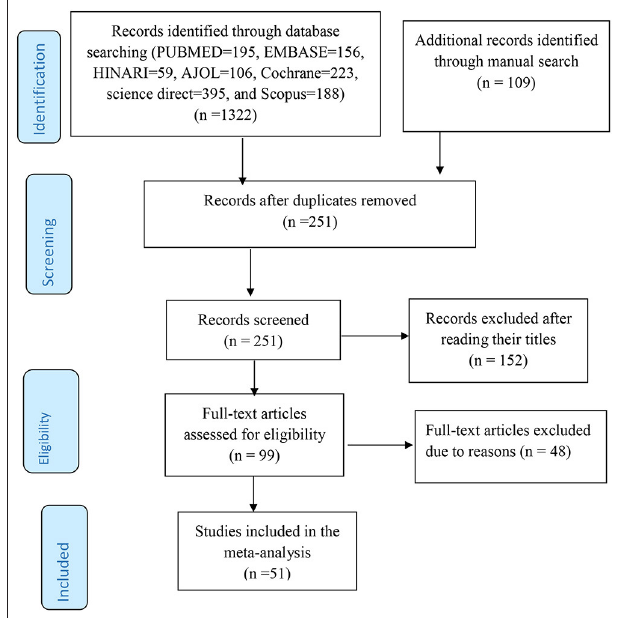
FIGURE 1 | The preferred reporting items for systematic reviews and meta-analyses (PRISMA) flow chart to screen the studies to be included in the